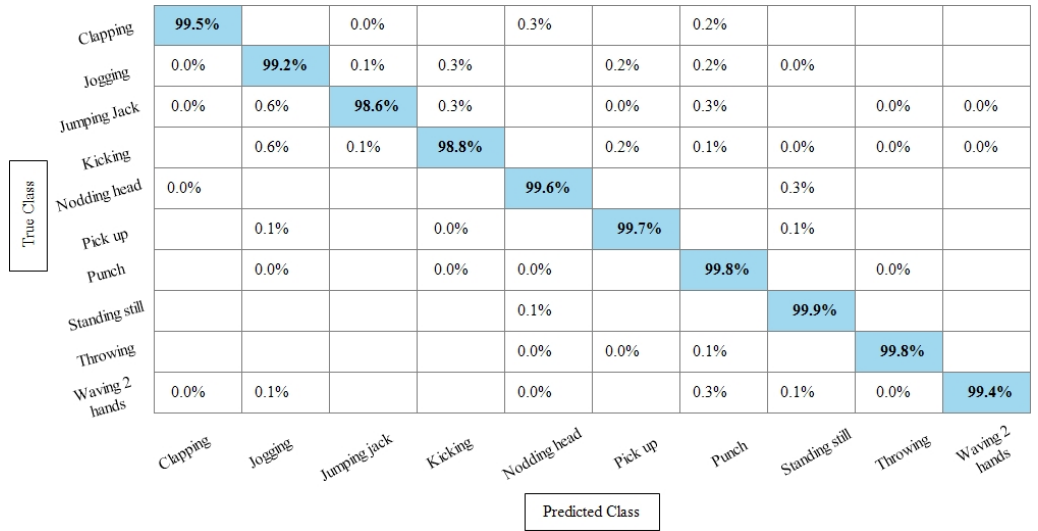
Figure 14. TPR-based confusion matrix of Cubic SVM after best feature selection using KcWKNN.